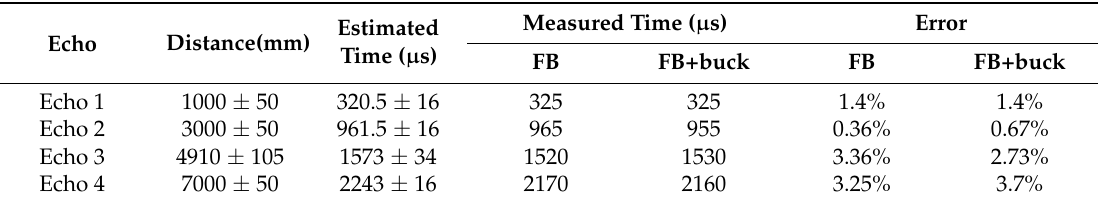
Table 5. Experimental results: Distance measurements.